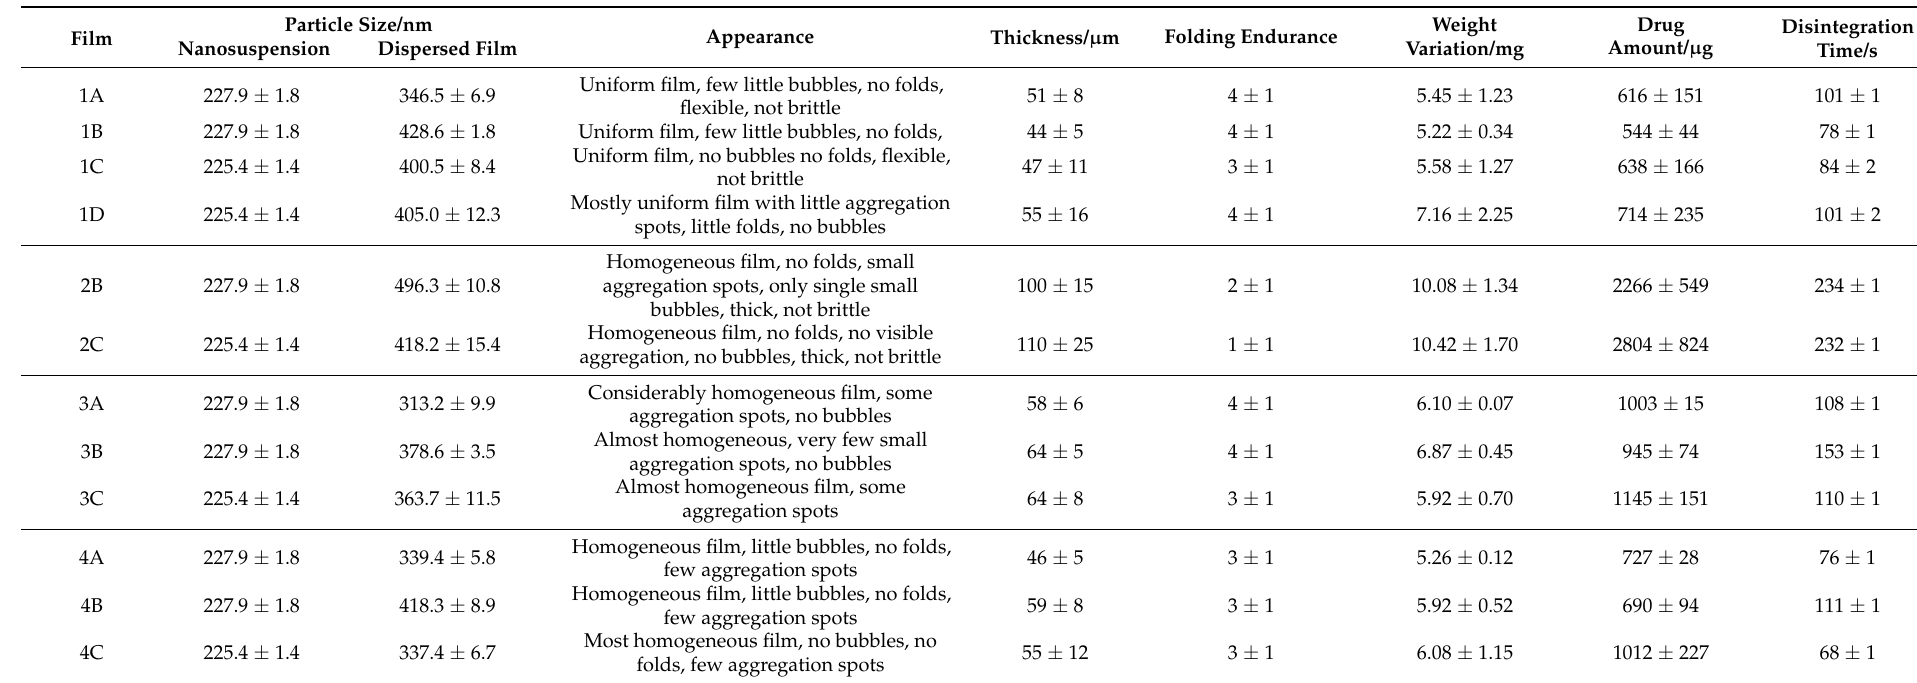
Table 4. Characteristics of the drug-loaded films: particle size values measured for the printing suspensions before printing and after film redispersion, appearance of the films, film thicknesses, folding endurance (number of foldings before the film is broken), weight variations, drug amounts, and disintegration time results (n =